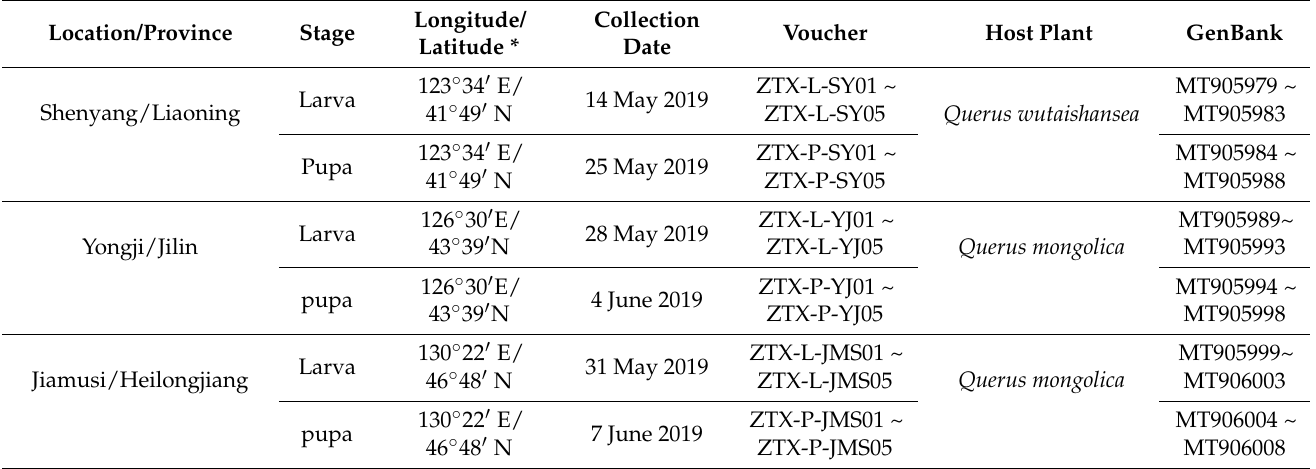
Table 1. Detailed information for the 30 specimens used for molecular